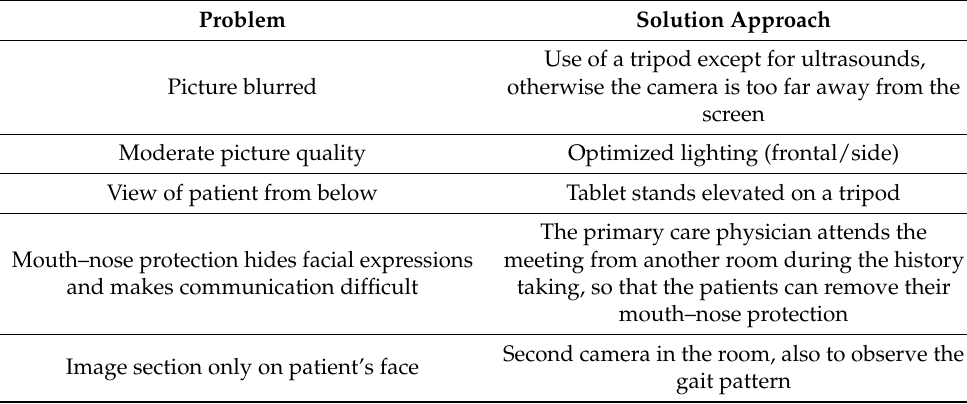
Table 1. Technical problems and approached